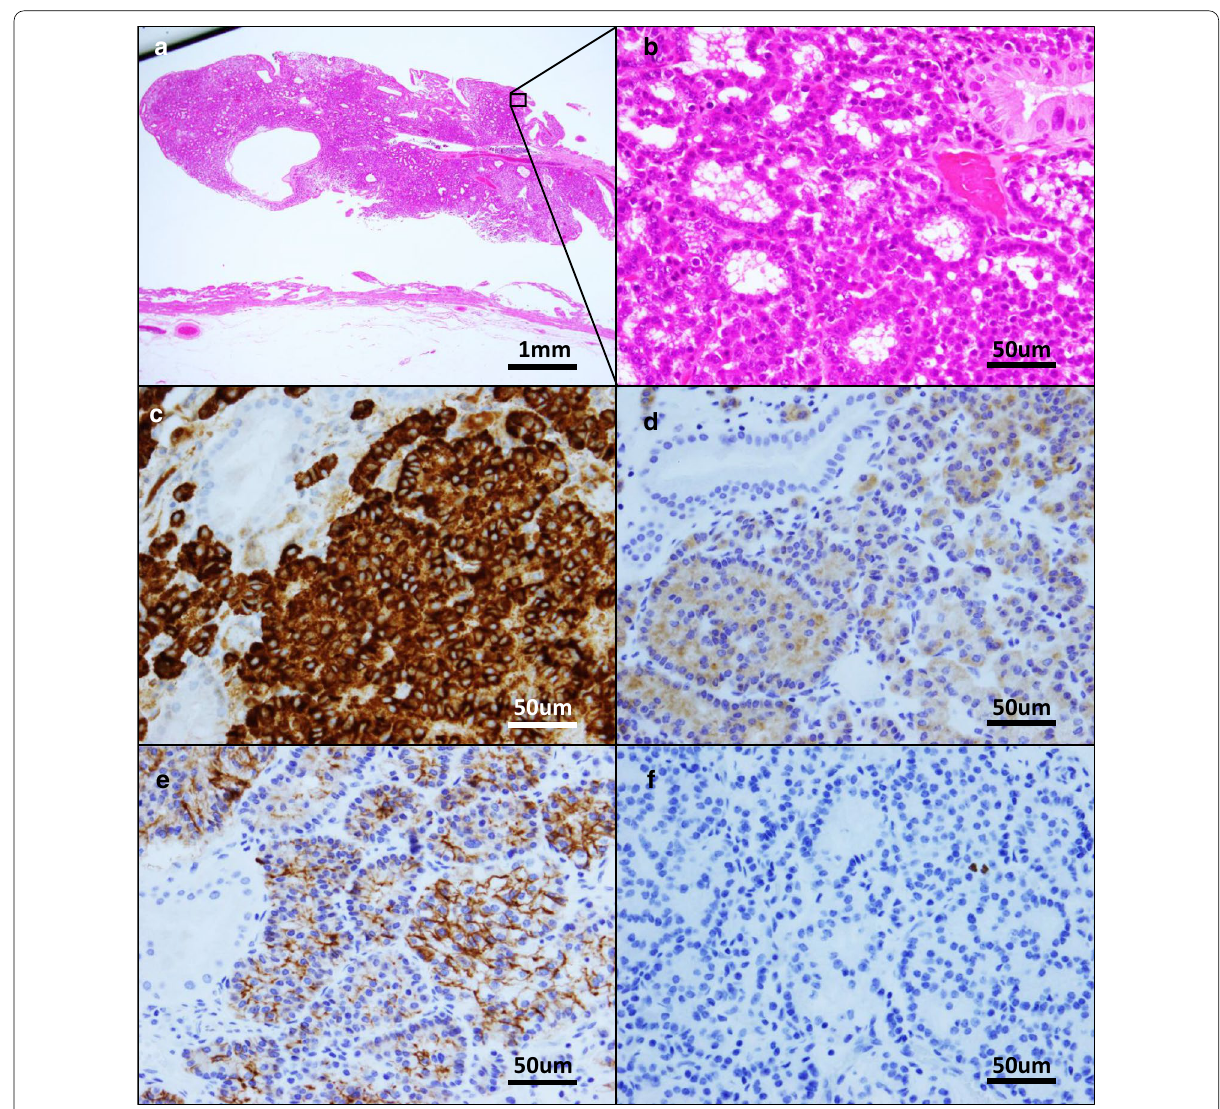
Fig. 4 Definitive diagnosis of a neuroendocrine tumor of the gallbladder relies on the pathological results. a , b Hematoxylin and eosin staining of the gallbladder tumor. Immunohistochemical staining showed positivity for c chromogranin A, d synaptophysin, and e CD56. f The Ki‑67 index was <